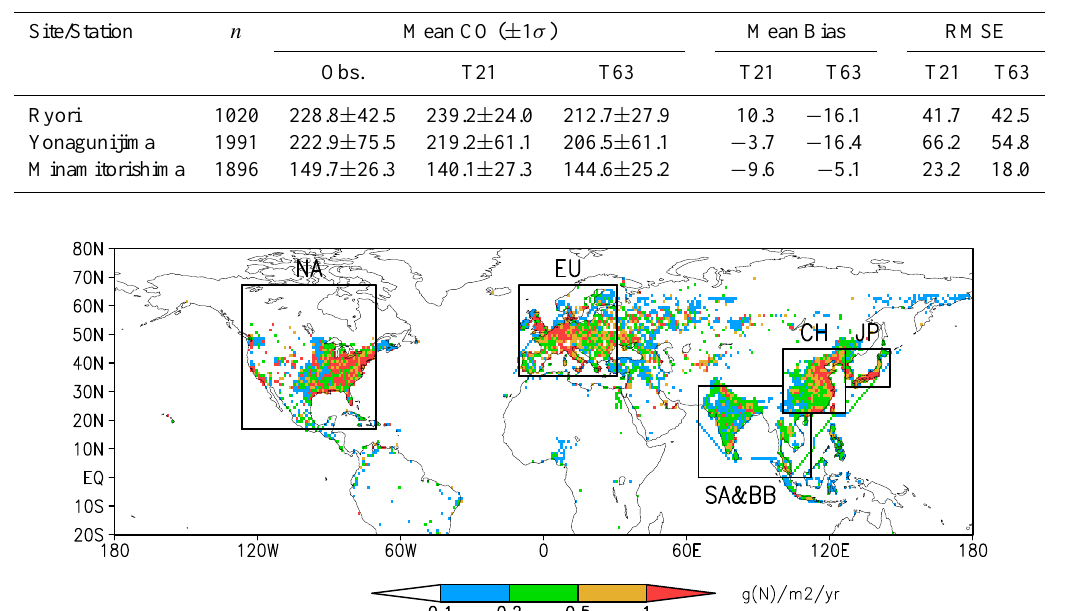
Fig. 5. Distribution of anthropogenic surface NO x emissions (g N m − 2 yr − 1 ) used in this study (Olivier et al., 1996; Streets et al., 2003) showing the principal source regions considered here.